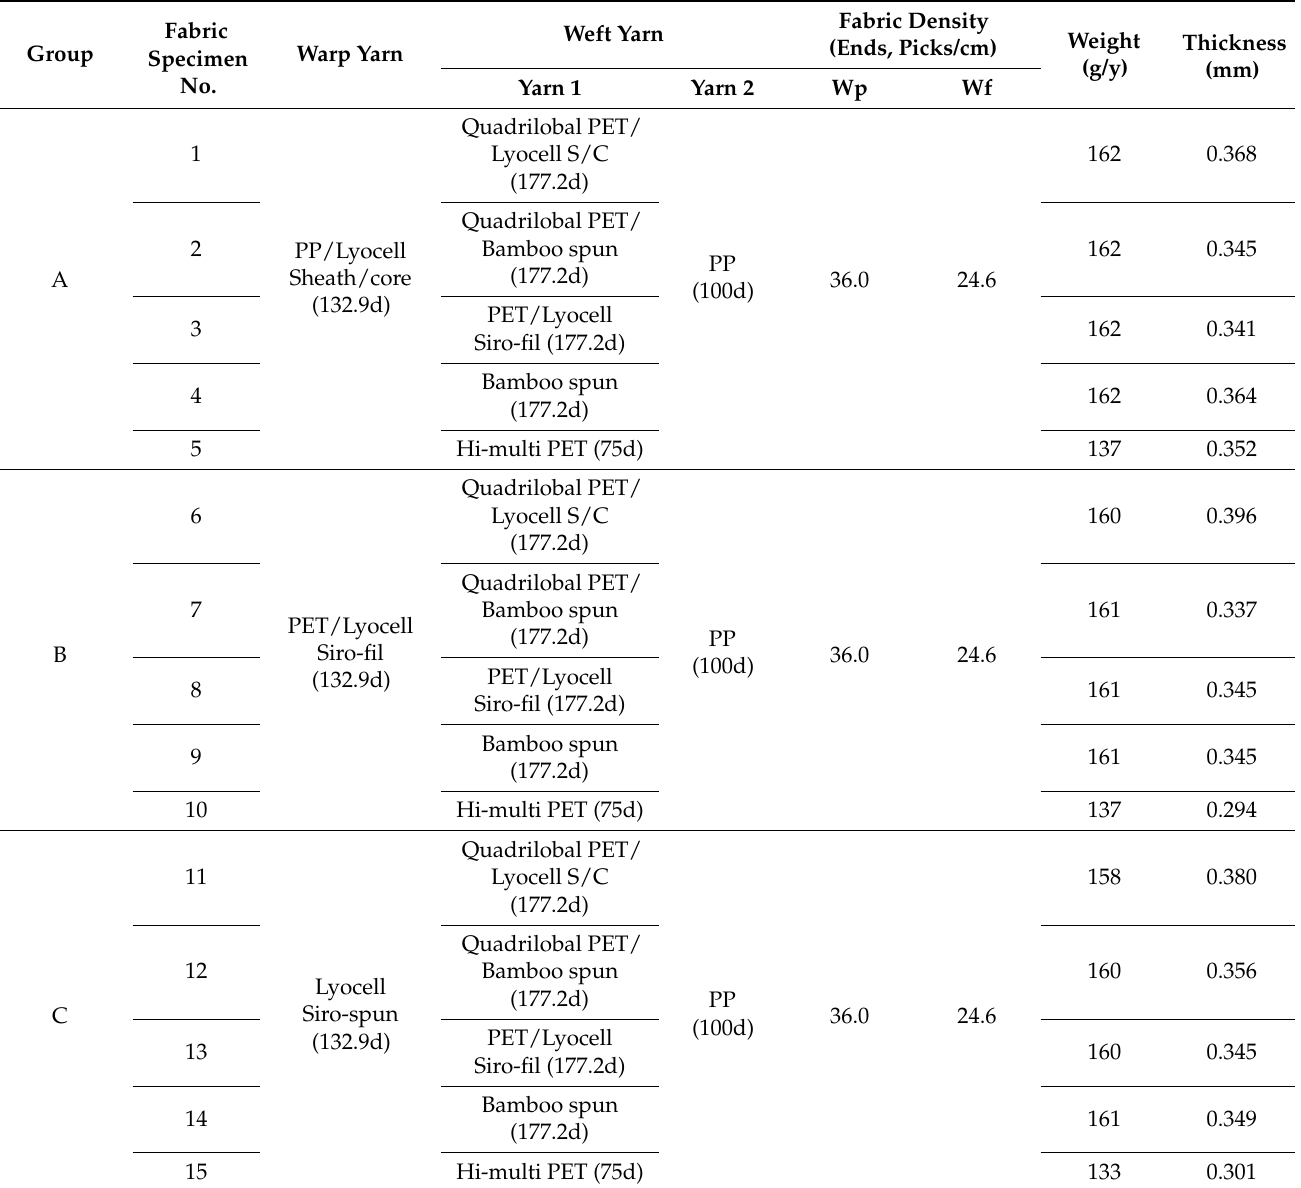
Table 2. Specification of three fabric